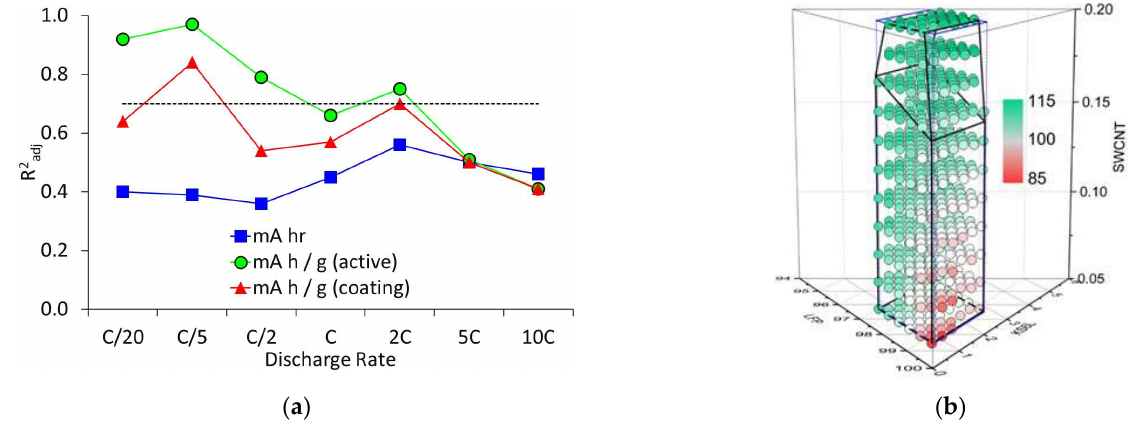
Figure 5. Calculations from mixture only model; ( a ) goodness of fit values, and ( b ) discharge capacities (mA h g −1 ) at 2C.